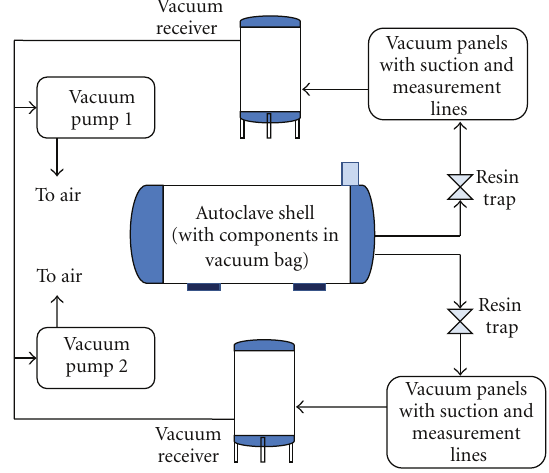
Figure 8: Schematic of vacuum